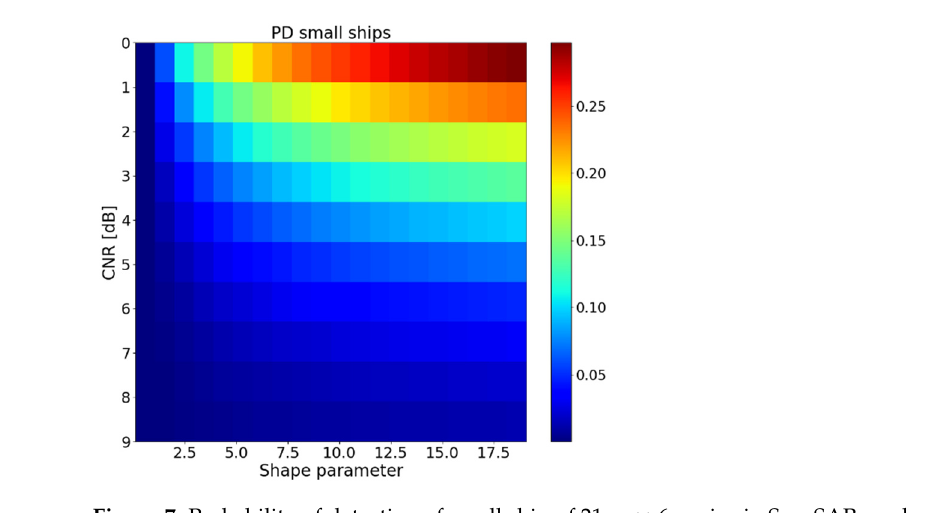
Figure 7. Probability of detection of small ship of 21 m × 6 m size in ScanSAR mode as a function of the CNR and shape parameter for a P fa = 1.26 × 10 − 7 .